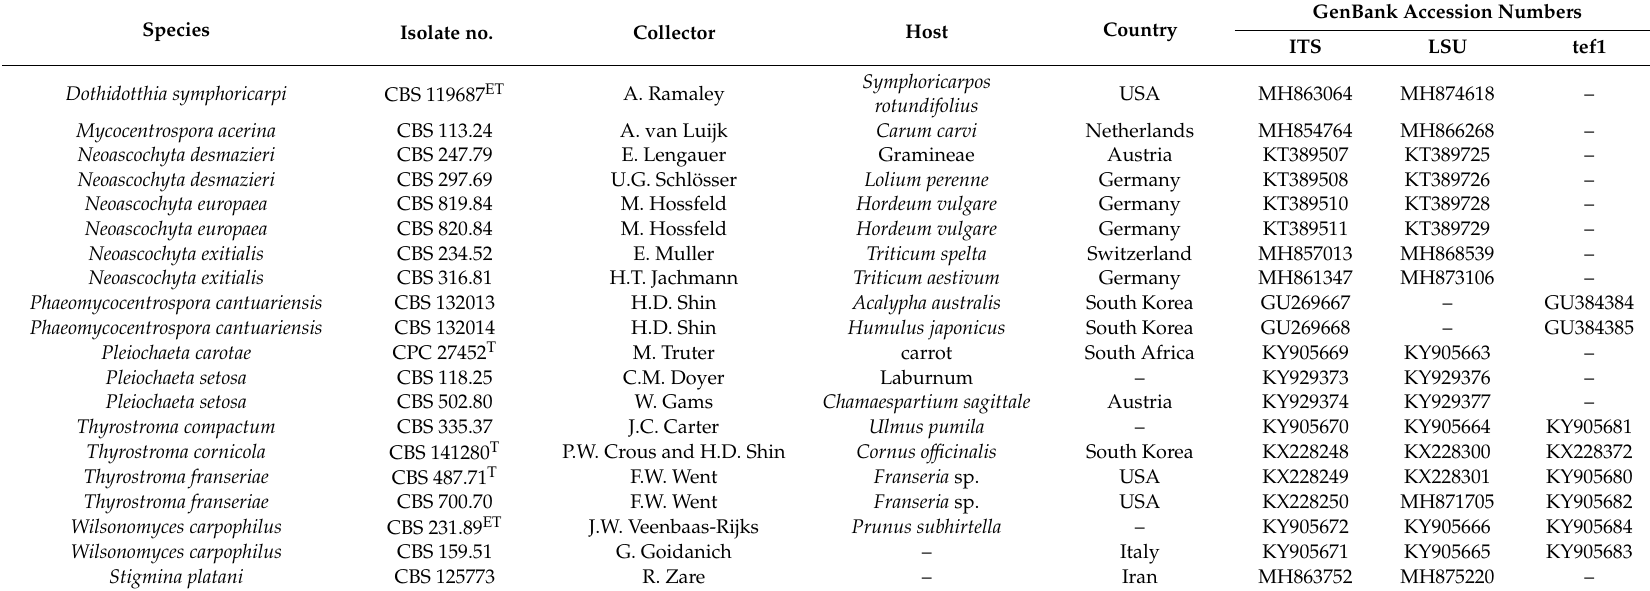
Table 2. Description of DNA sequences used in phylogenetic